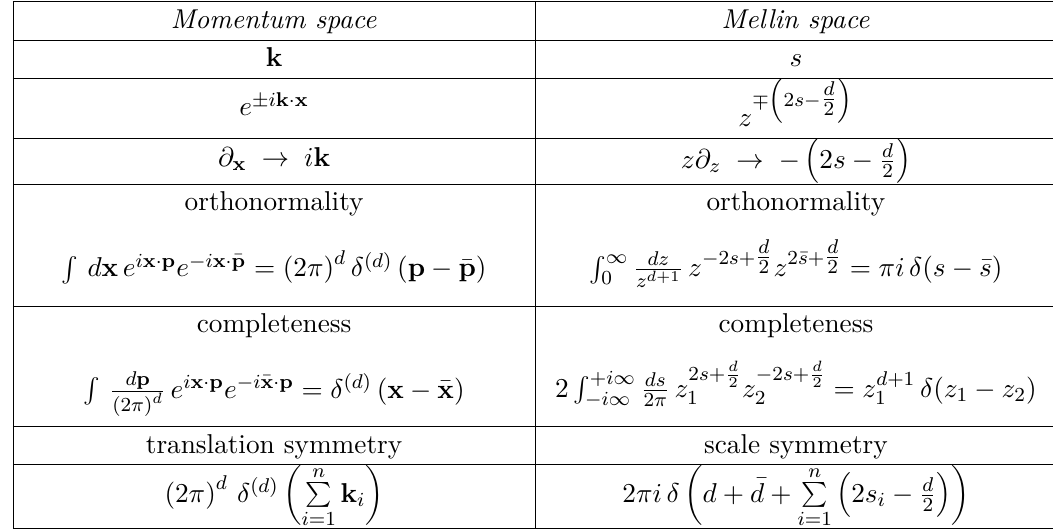
Table 1. Summary of parallels between momentum space and the Mellin-Barnes